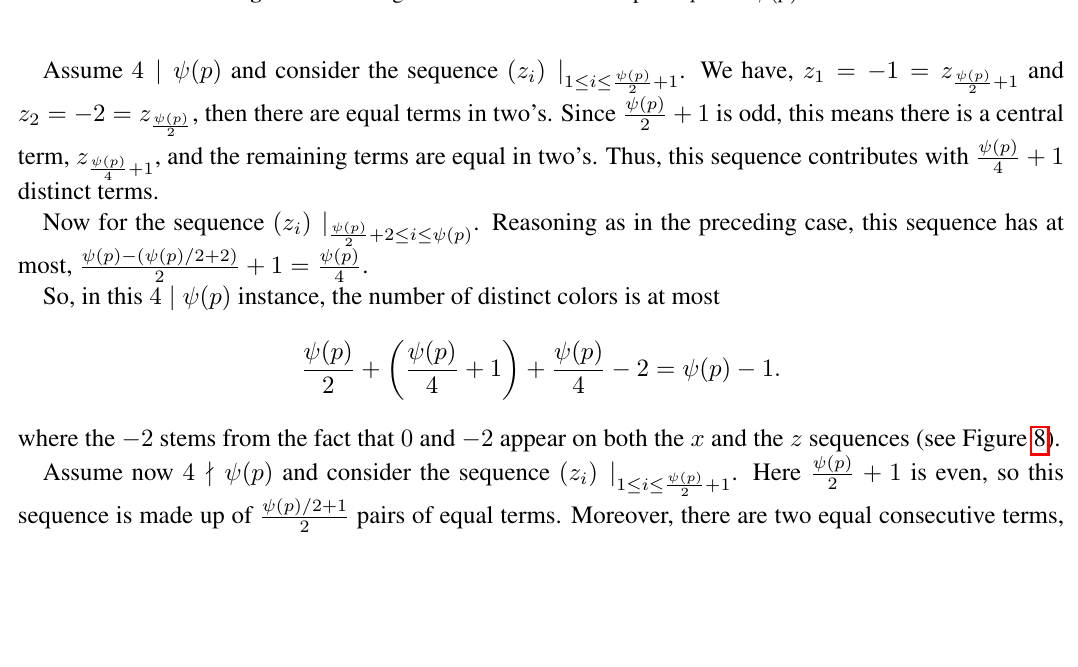
Fig. 8: Minimizing the number of colors for prime p with ψ ( p )